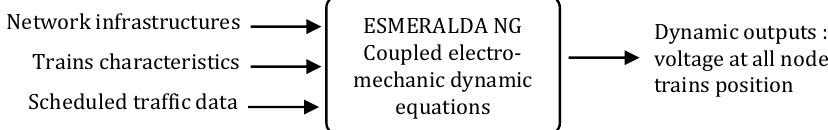
Figure 1. Railway simulator ESMERALDA NG.